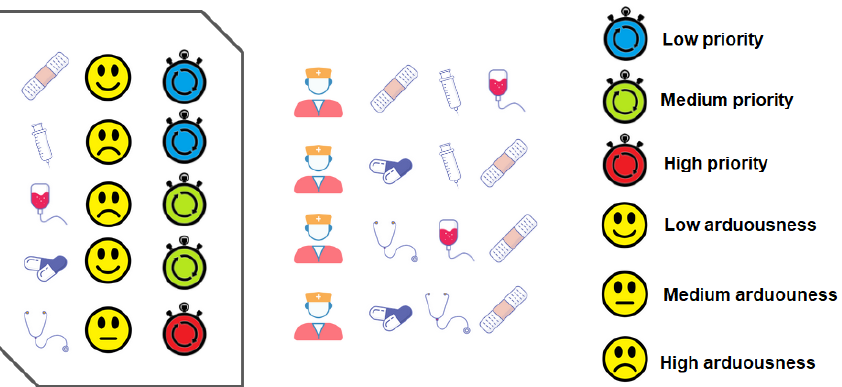
Figure 1. An example of priority and arduousness in an HCC scheduling problem.